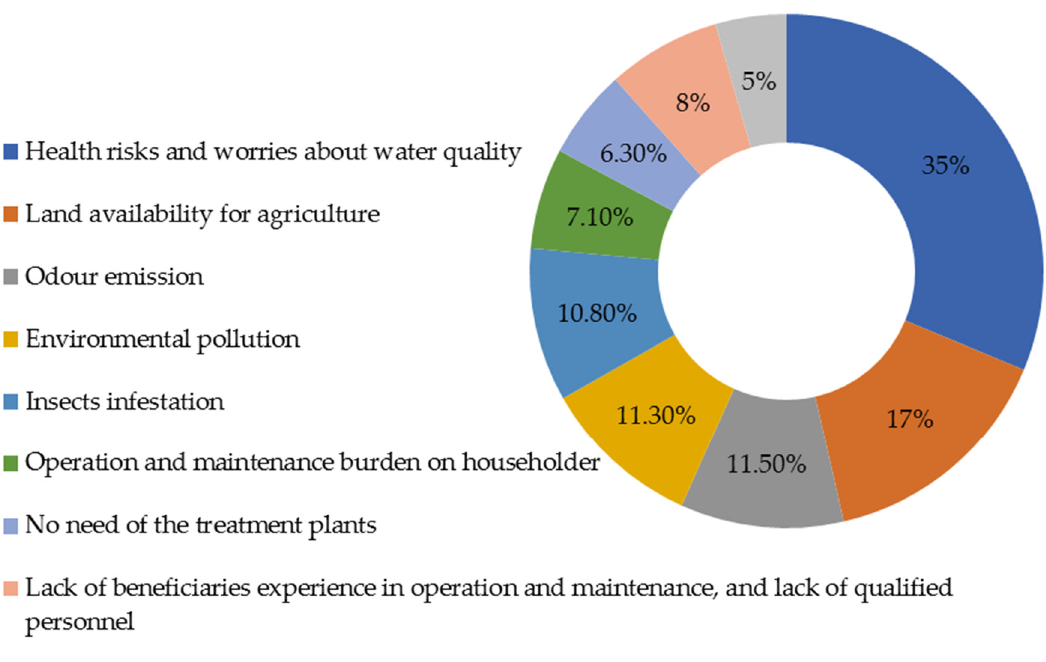
Figure 7. Barriers for accepting onsite GWTPs by the cesspits owners.